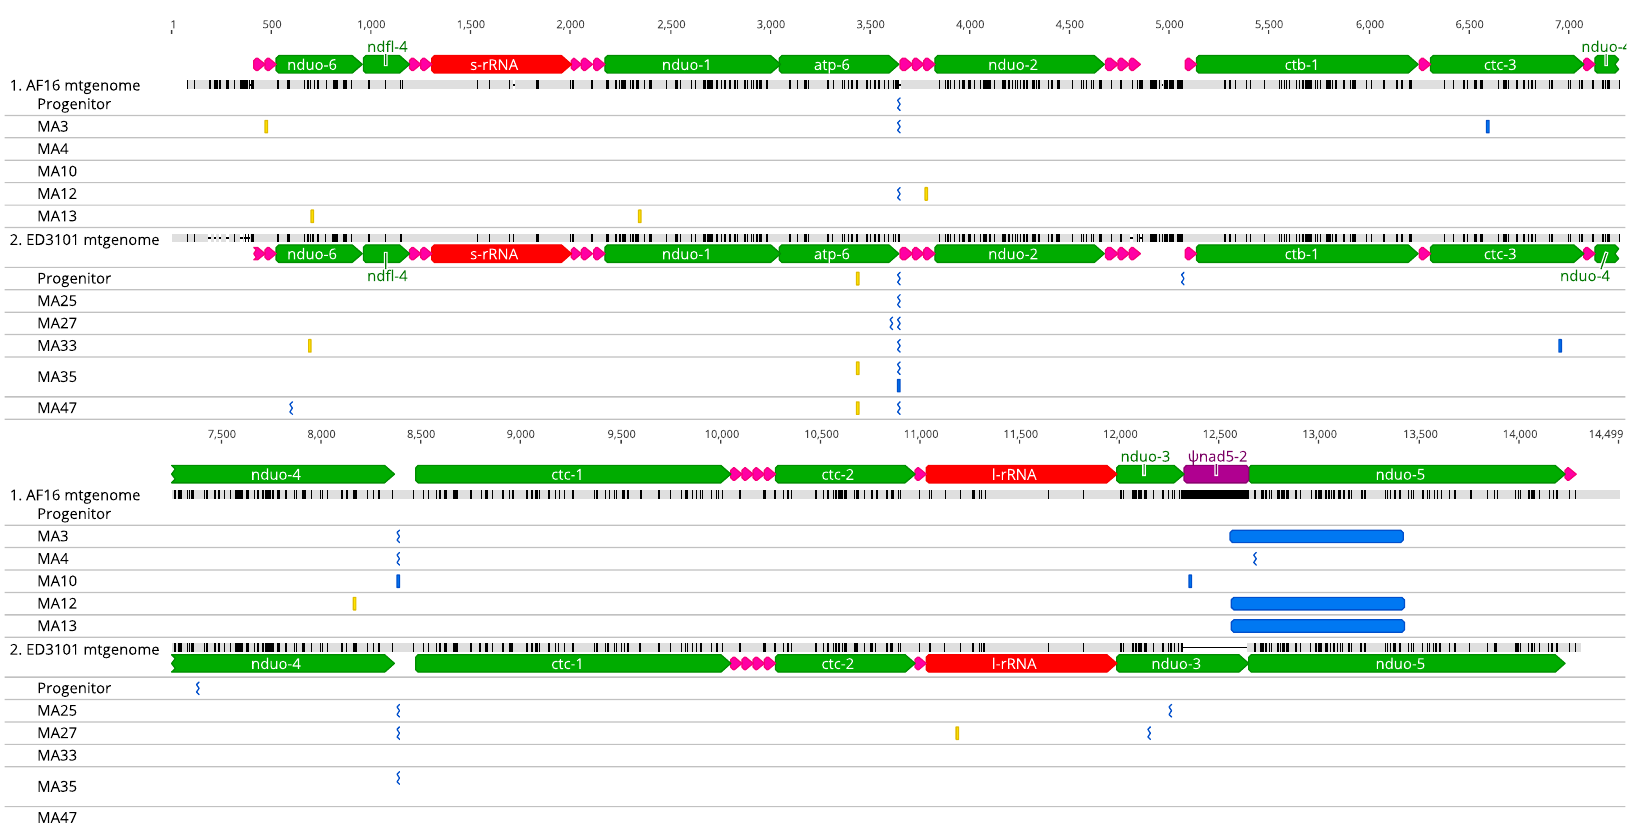
Figure 1. Mitochondrial DNA heteroplasmy in AF16 and ED3101 C. briggsae MA lines. The AT-rich region is omitted in alignment and position numbers are relative to the beginning of the alignment. For heteroplasmy events in the progenitor and MA lines, SNPs are represented in orange while insertion (jagged symbol) or deletion (straight symbol) events are represented in blue. Alignment consensus disagreements between AF16 and ED3101 reference mitochondrial genome sequences are in black, while agreements are in grey (overall 93.5% pairwise sequence identity).